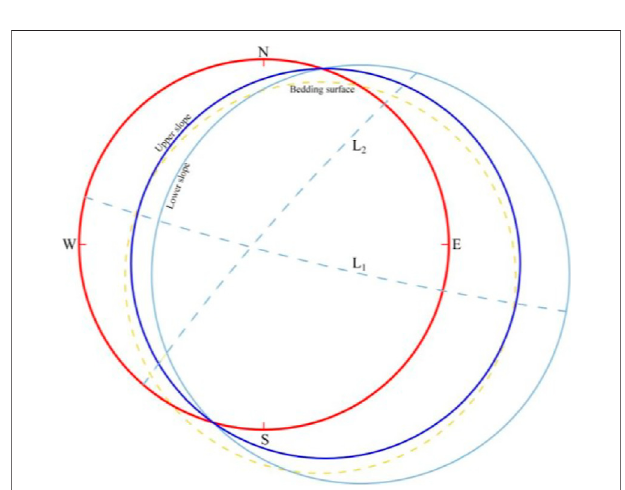
FIGURE 6 | Whole-space stereographic projection of the